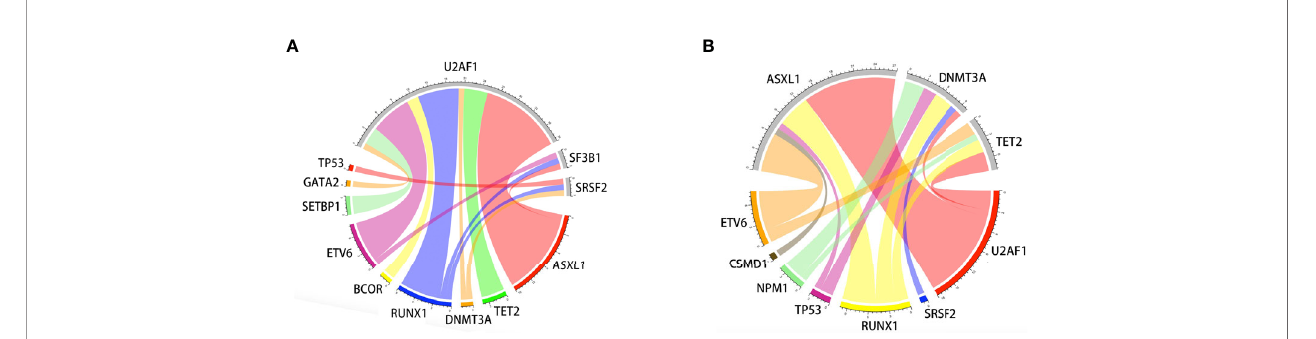
FIGURE 1 | Associations of gene mutations in the MDS patient cohort outlined by a Circos diagram. Mutations in genes of the splicing machinery (U2AF1, SF3B1, and SRSF2) were associated with ASXL1 (gene belonging to the epigenetic regulation). Splicing machinery genes were mutually exclusive (A) . Mutations in genes of epigenetic regulation were associated with RUNX1 (gene belonging to transcriptional factors) (B) .